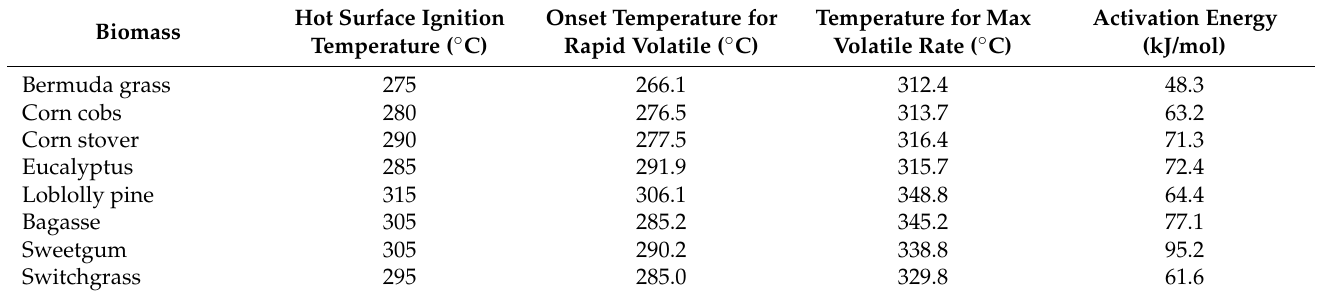
Table 8. Hot surface ignition temperature and volatilization temperature of herbaceous and woody biomass [72].